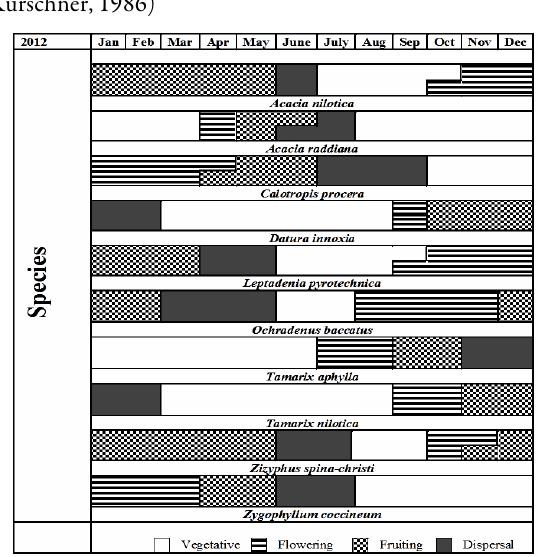
Fig. 3. Phenological spectrum of selected ten species from the study area of wadi El-Assuity during